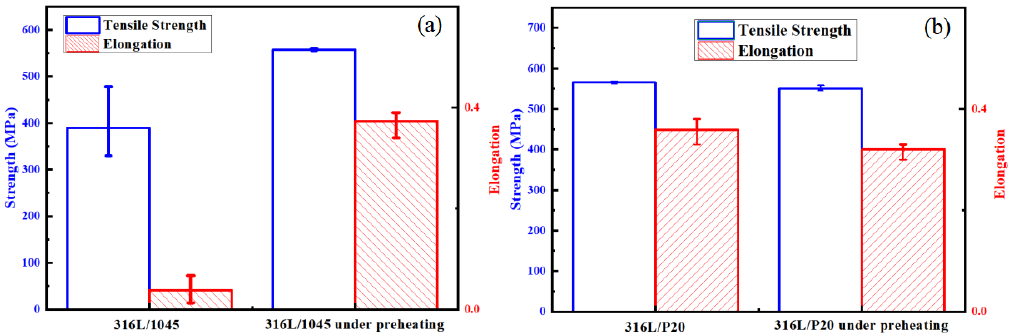
Figure 11. Static mechanical properties of different hybrid-processed samples: ( a ) 1045 with 316 L; ( b ) P20 with 316 L.